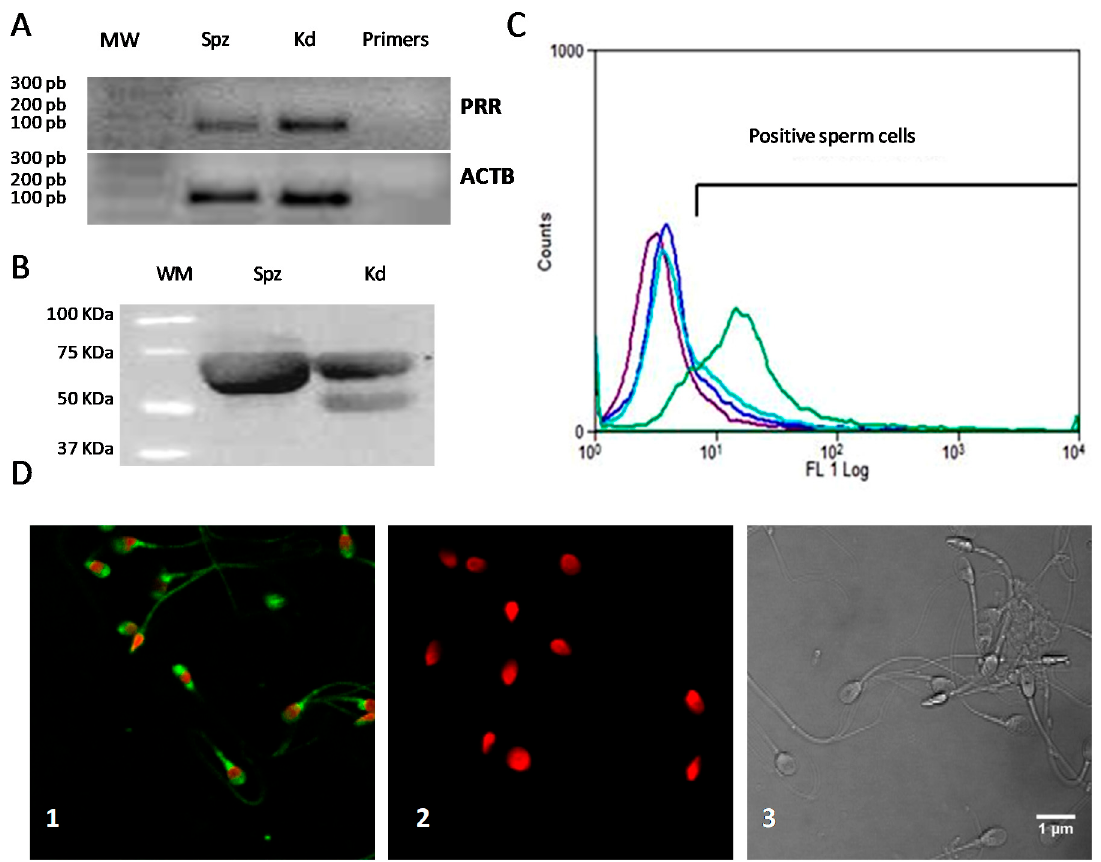
Figure 1. Expression and localization of PRR in human sperm cells. ( A ) A representative of midori-green-stained gels of the RT-PCR products for ATP6AP2 and ACTB in human sperm from a pool of five normozoospermic semen samples (Spz) and kidney (Kd). Primers without cDNA were used as negative control. ( B ) A representative immmunoblot of PRR in human sperm from a pool of five normozoospermic samples (Spz) and kidney (kd). ( C ) A representative plot of PRR-positive sperm population analyzed by flow cytometry. Plots of blank control (purple) without both primary and secondary antibodies, negative primary antibody control (light blue) as the same concentration as the primary antibody and with secondary antibody, negative secondary antibody control (deep blue) with secondary antibody alone, and plot of PRR-positive sperm population (green). Nucleuses were stained with Hoescht 33258. n = 2. ( D ) Immunofluorescence analysis of the PRR in human sperm cells. ( D1 ) PRR Positive sperm cells (green). ( D2 ) Negative secondary antibody control (red). ( D3 ) Phase-contrast image of the human sperm cells. Nucleuses were stained with Hoescht 33258. Representative photomicrographs are shown; n = 3. Scale bar: 1 µm.